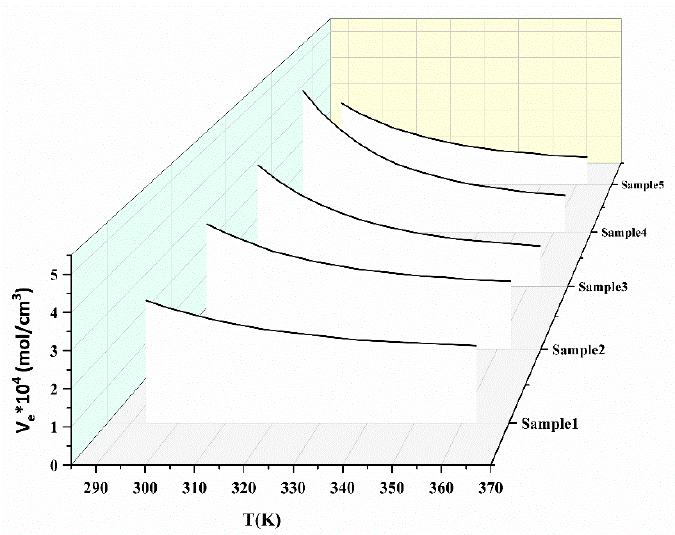
Figure 7. Elastic modulus of pseudo-semi IPNs as a function of temperature.